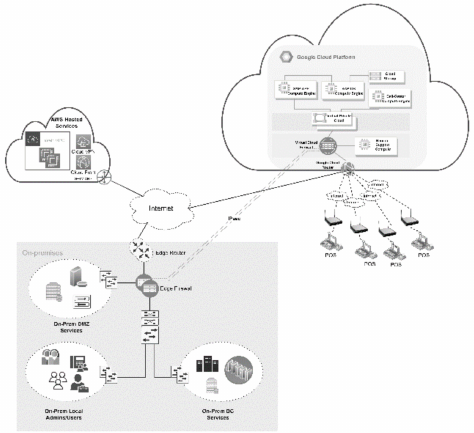
Figure 3. The scenario technology